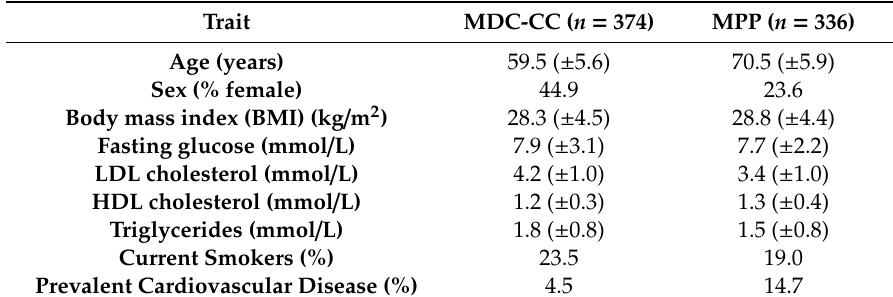
Table 1. Characteristics of the participants in the Malmö Diet and Cancer-Cardiovascular Cohort (MDC-CC) and Malmö Preventive Project